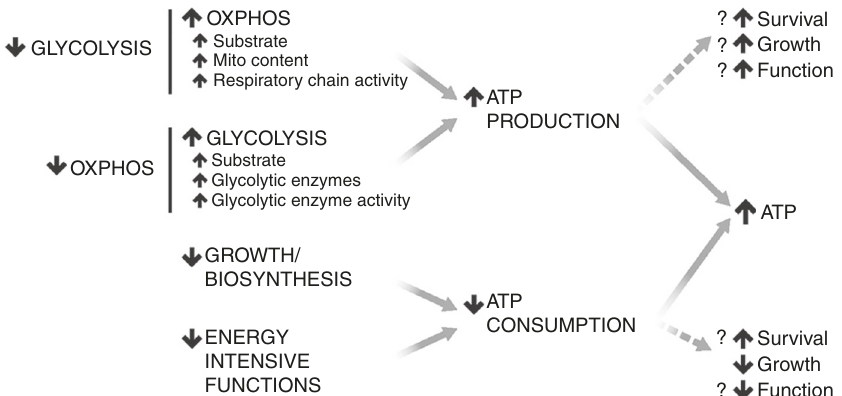
Fig. 7 Mechanisms by which cells can increase ATP and the potential consequences. ATP levels may increase due to increased ATP production or decreased consumption. Increased production may result from either increased oxidative phosphorylation (OXPHOS) or glycolysis, and inhibiting either of these processes stimulates the other. The impact of increased ATP on cellular functions, growth, and survival likely depends on the mechanism by which ATP is increased, in addition to the speci fi c